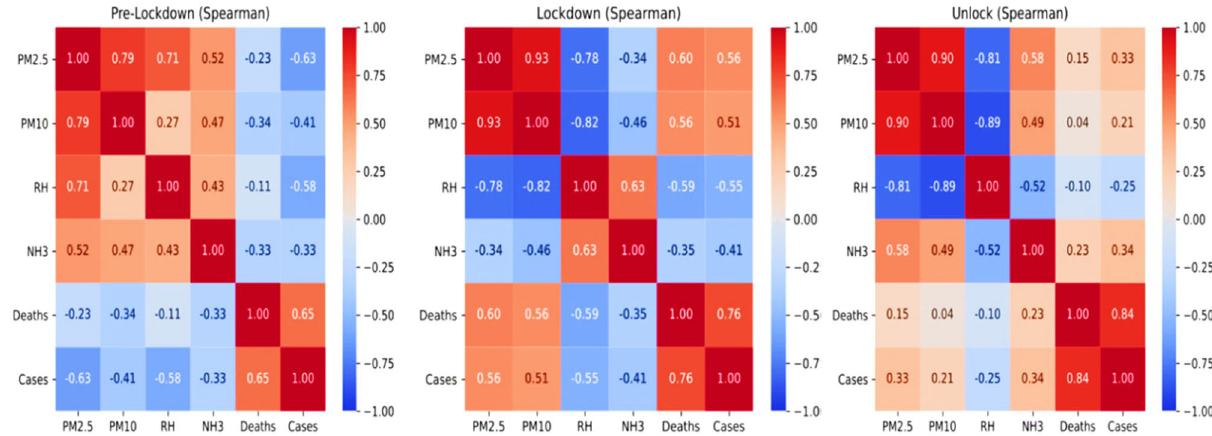
Figure 7. Spearman correlation plots amongst different variables for pre-lockdown phase, lockdown phase, and unblock